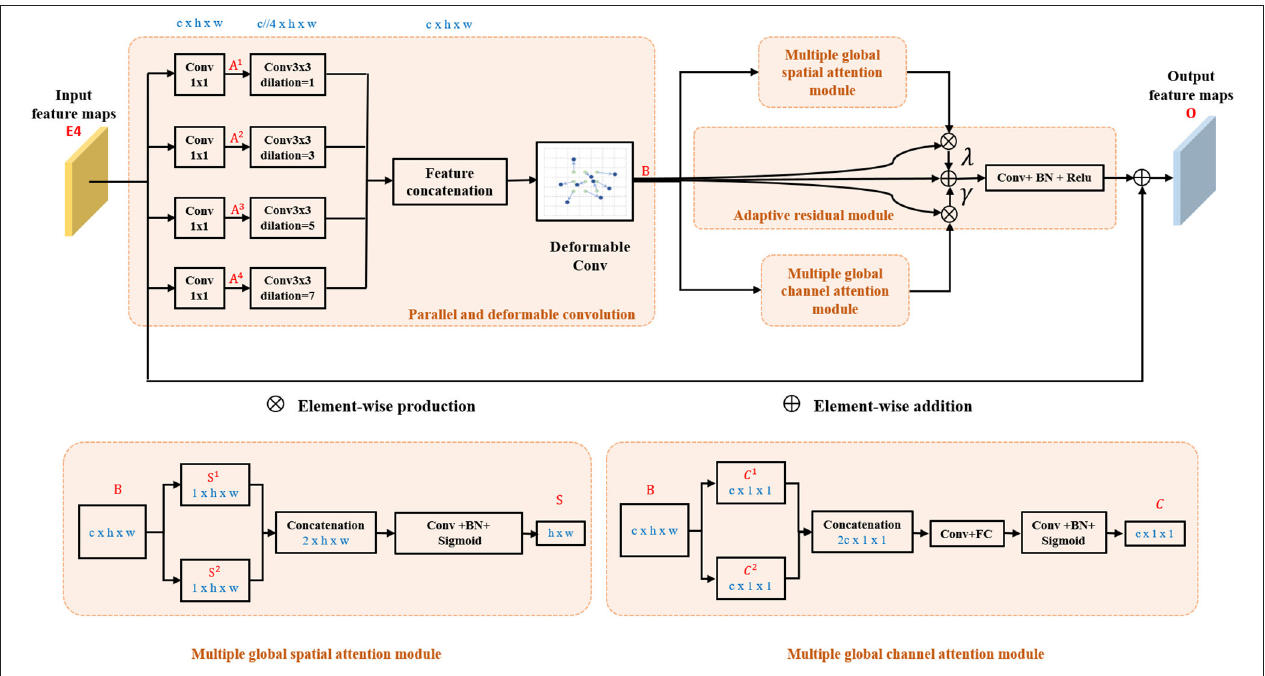
FIGURE 2 | Architecture of the proposed multi-scale adaptive-aware deformation module